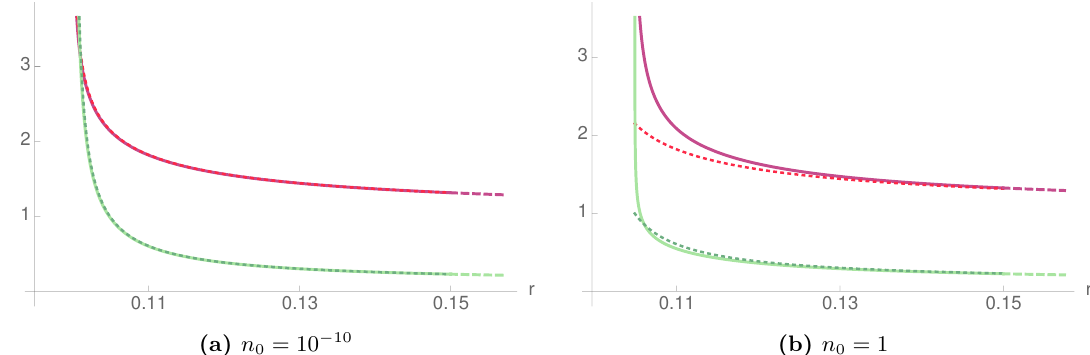
Figure 1. Numerical solutions obtained by imposing boundary conditions at r = 2 , with g s = . 1 , c 1 = 0 , for different values of n 0 . In solid red (green) we show the behavior of e A ( e φ ) compared to the behavior of the perturbative solution (dotted). For n = 10 − 10 the functions are indistinguishable, but 0 for n = 1 the functions deviate from the perturbative ones, approaching the O4 singularity (3.47). 0